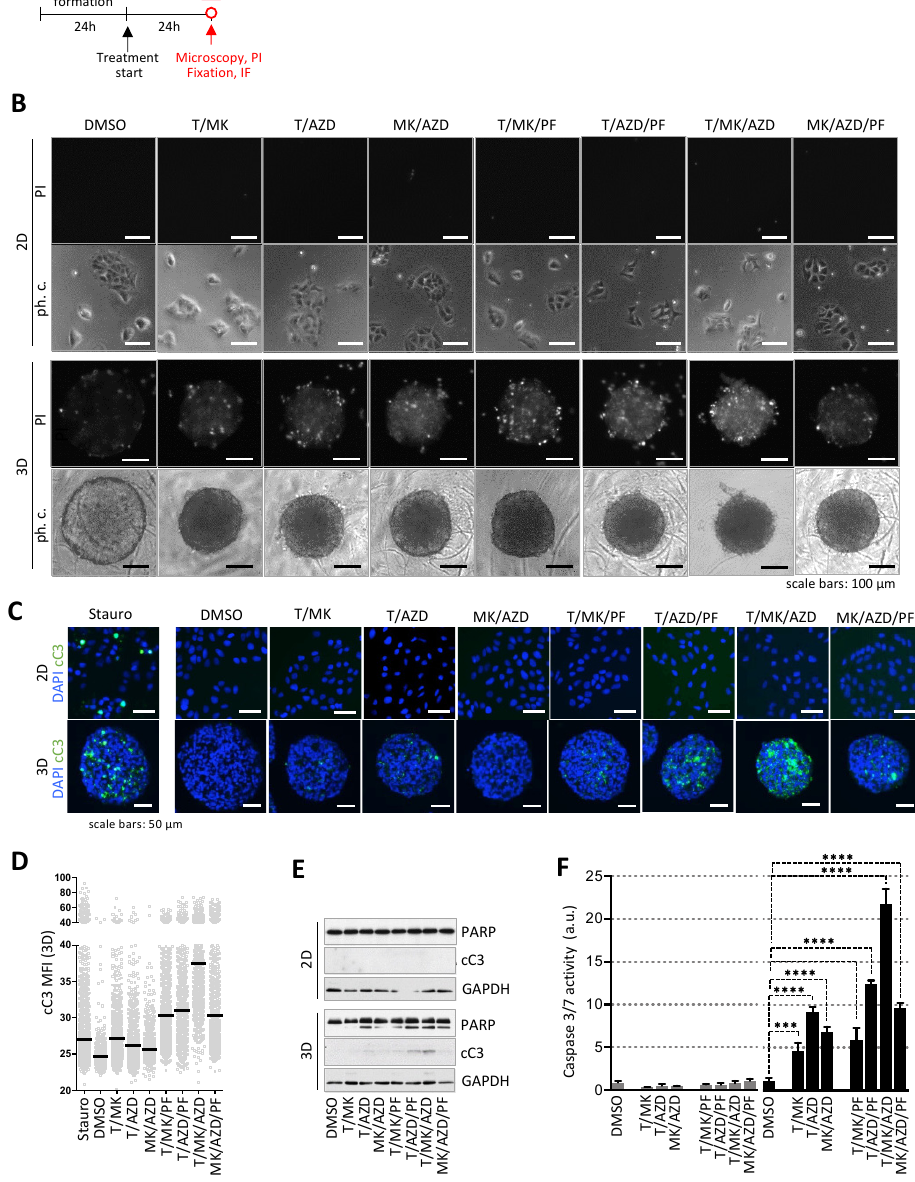
Figure 2. Assessment of cell death upon treatment. ( A ) Overview of the time frame of the experi- ment. ( B ) DLD-1 cells were incubated with dual and triple inhibitor combinations of T (250 nM), PF (10 µM), MK (1 µM) and AZD (1 µM) for 24 h. DMSO served as control. Subsequently, cells in 2D and 3D were stained with 2 µg/mL propidium iodide (PI) staining dead cells. Representative phase contrast and fluorescence images are shown. Scale bars represent 100 µm. ( C ) Cells and spheroids were treated as in ( A ), fixed and subjected to immunofluorescence analysis for cleaved caspase 3 (cC3, Asp175, green) as a marker for apoptosis. Nuclei are stained with DAPI (blue). Staurosporine (1 µM) was used as positive control. Representative images are shown. Scale bars represent 50 µm. ( D ) cC3 fluorescence intensity per cell of images from the 3D cultures (10 sections per condition) was measured in ImageJ using DAPI for segmentation. Each grey dot represents one cell, mean